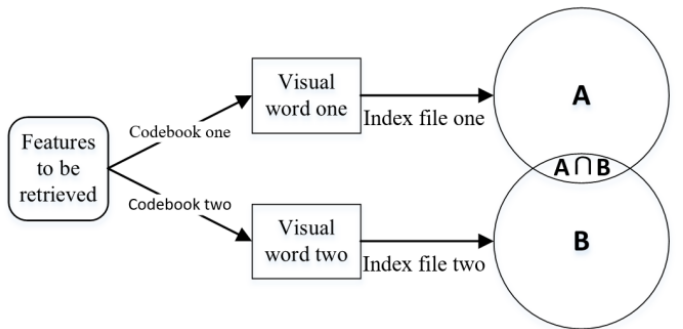
Figure 4. Codebook correlation problem.